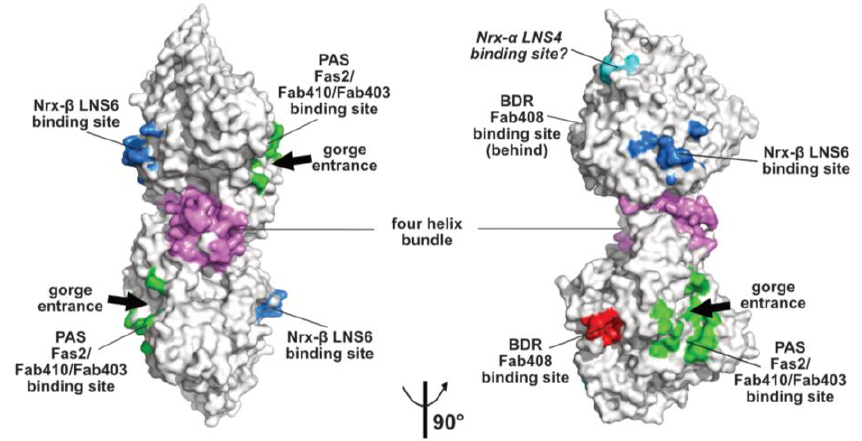
Figure 2. Overall views, oriented 90° from each other, of the mAChE dimer in surface mode with the binding surfaces for the peptidic ligands Fas2 (PDB code, 1KU6), Fab410 (modeled from PDB code 4QWW) and Fab403 at the AChE PAS displayed in green, those for Fab408 in the back door region of AChE in red, those for neurexin-β or the neurexin-α LNS6 domain on neuroligins NLG1 and NLG4 in blue (modeled from PDB code 2XB6), and those for the neurexin-α LNS4 domain on neuroligins in cyan. Helices α3(7,8) and α10 in the dimer four-helix bundle are displayed in violet.